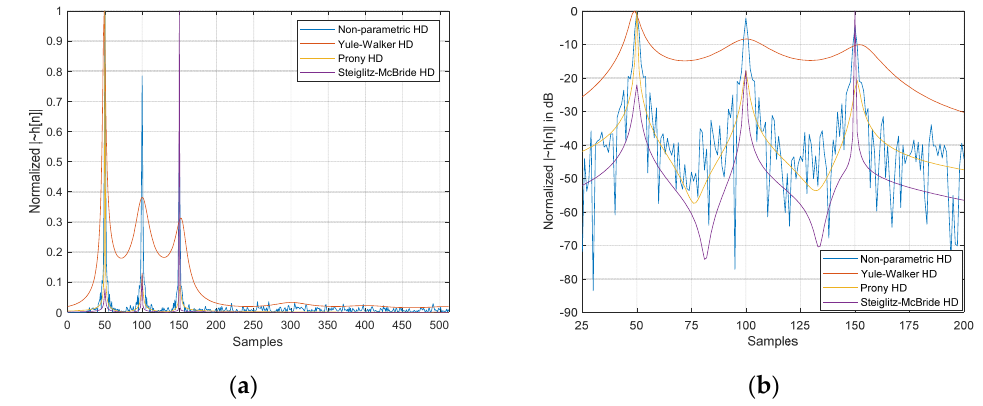
Figure 3. Estimated (cid:3627)ℎ(cid:3560) [ 𝑛 ] (cid:3627) distribution (normalized), with 200 ensemble average lengths for 50, 100, and 150 sample delays. The order for the parametric HDs is 9 and the window length for all HDs is 25 samples. ( a ) Magnitude distribution; ( b ) decibel distribution. ℎ(cid:3560) [ 𝑛 ] is represented by ~ ℎ [ 𝑛 ] .